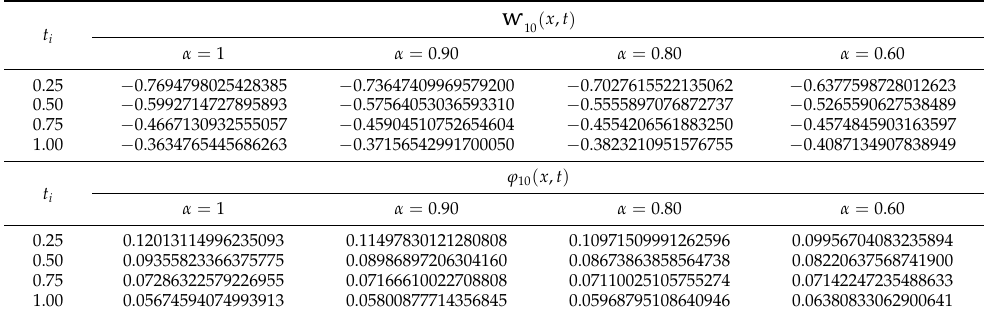
Table 4. Numerical results of approximate solutions, at n = 10, with different values of α , for Example 2.